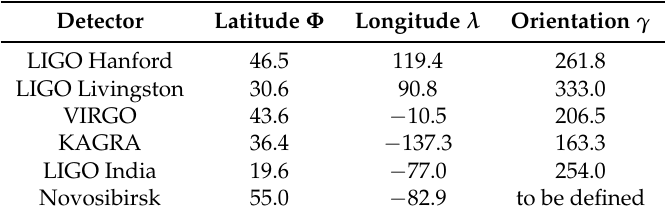
Table 1. Detector data (from [11–13]); all angles given in